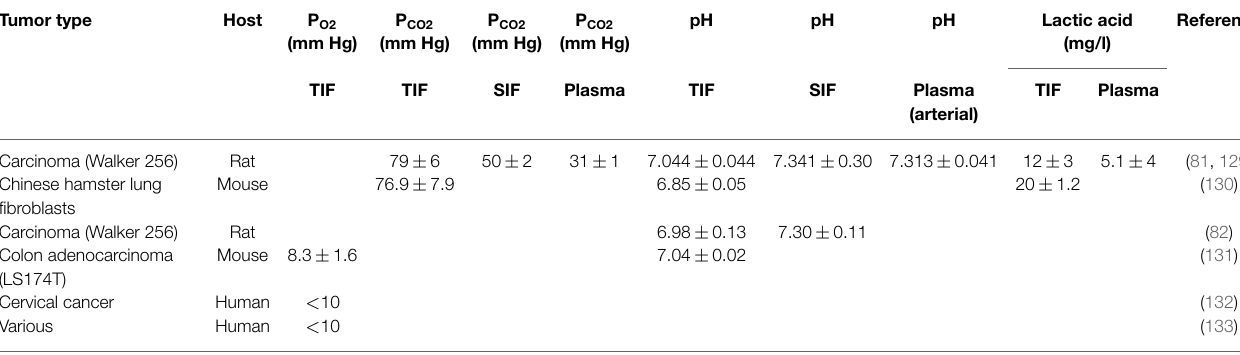
TABLE 1 | Composition of interstitial fluid in tumors . Tumor type